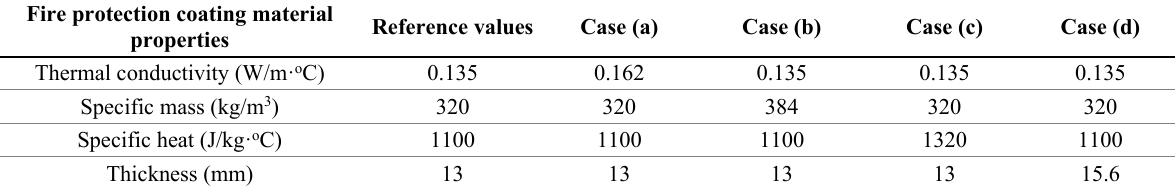
Table 6. Values of the properties of the fire protection coating material for the cases analyzed.